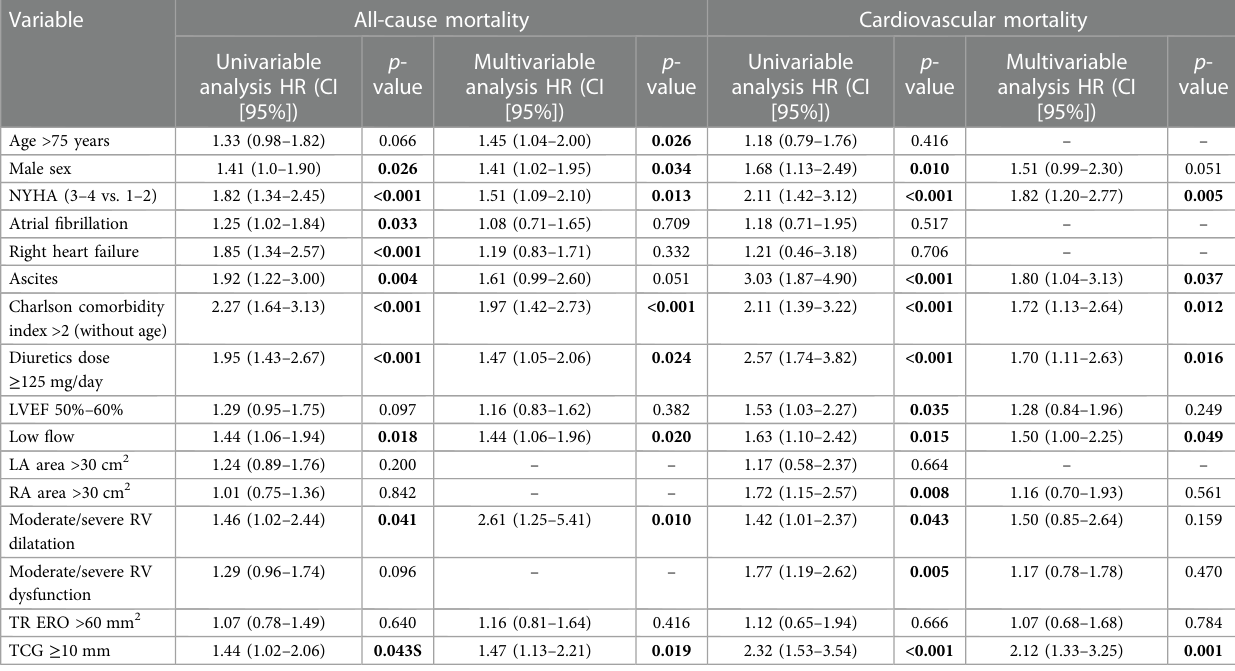
TABLE 2 Clinical and echocardiographic factors associated with all cause and cardiovascular mortality in the study population.